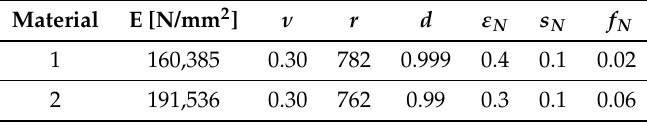
Table 3. Initial parameters for FEM models of both